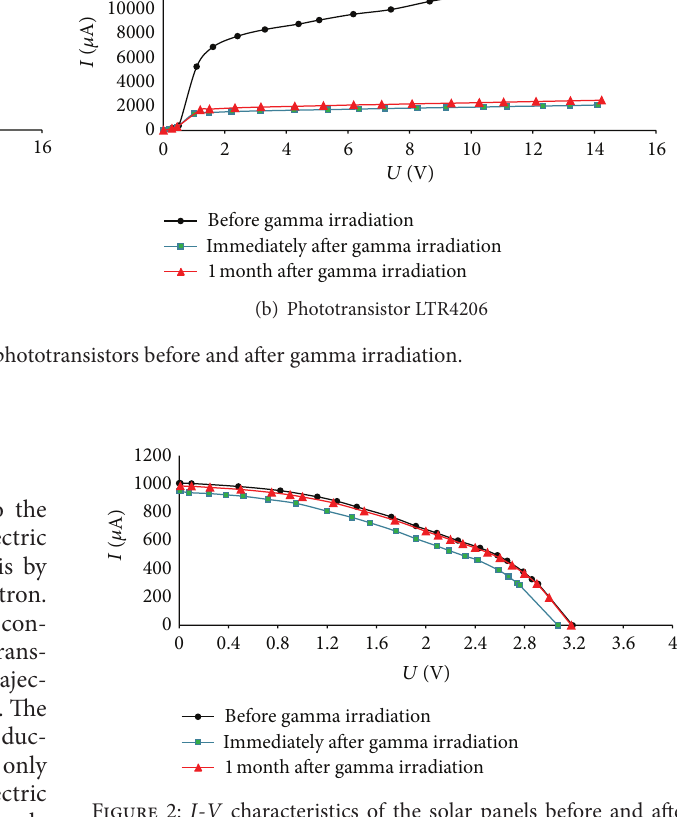
Figure 2: I - V characteristics of the solar panels before and after gamma